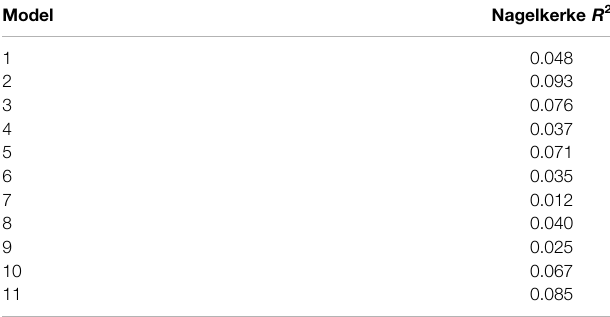
TABLE 7 | Nagelkerke R-squared goodness-of- fi t.